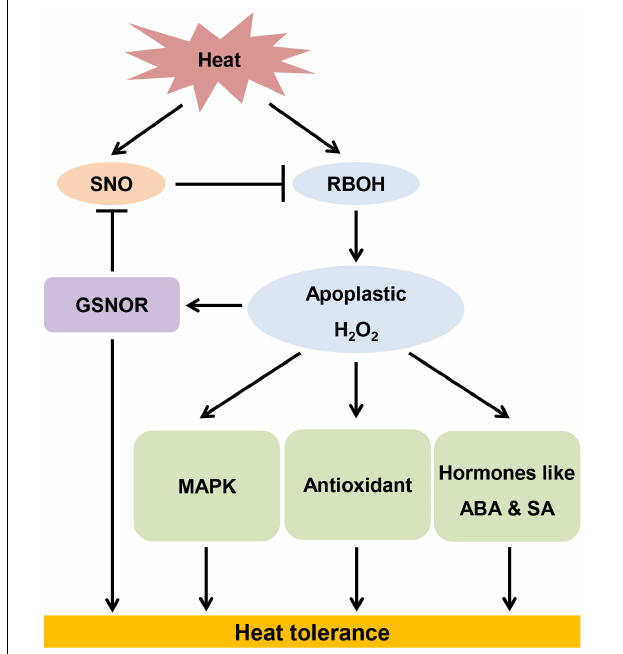
FIGURE 9 | The model of S -nitrosoglutathione reductase contributing to thermotolerance by modulating high temperature-induced apoplastic H 2 O 2